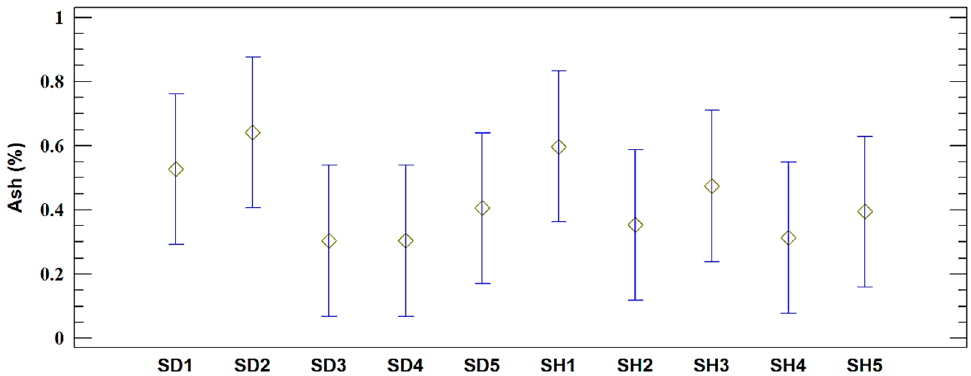
Figure 5. Ash content in the sawdust (SD) and shavings (SH) samples (%). The ash content for the shavings samples ranged from 66.91% (±1.02) to 90.88% (±1.05), with an average value of 83.60% (±9.80) (Figure 6).